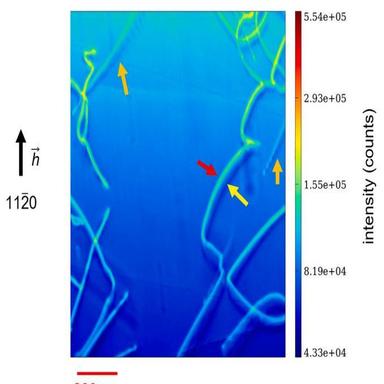
Topograph that shows the integrated intensity diffracted (1120 reflection, 20 keV) by of a 0.4 mm thick (0001) AlN crystal. The red / yellow arrow indicates the direct / dynamical image of a dislocation nearly parallel to the main surface. Two orange arrows show the images of threading dislocations that exhibit, in between the direct and dynamical images, the fringes that constitute the intermediary image. (For interpretation of the references to colour in this figure legend, the reader is referred to the w